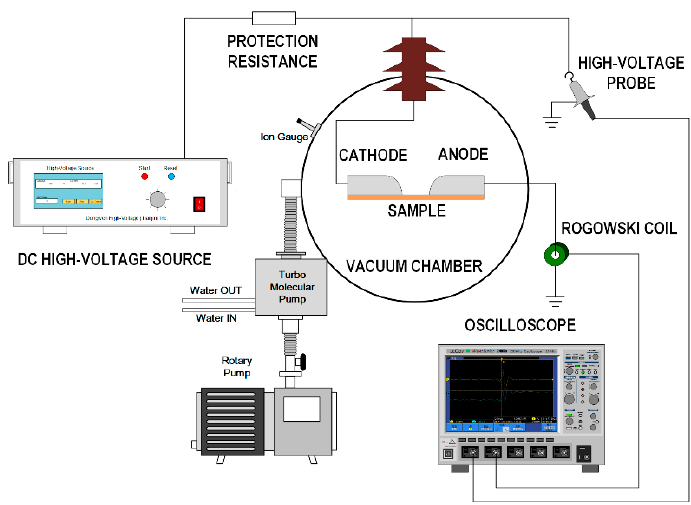
Figure 2. Vacuum DC surface flashover voltage measurement system.